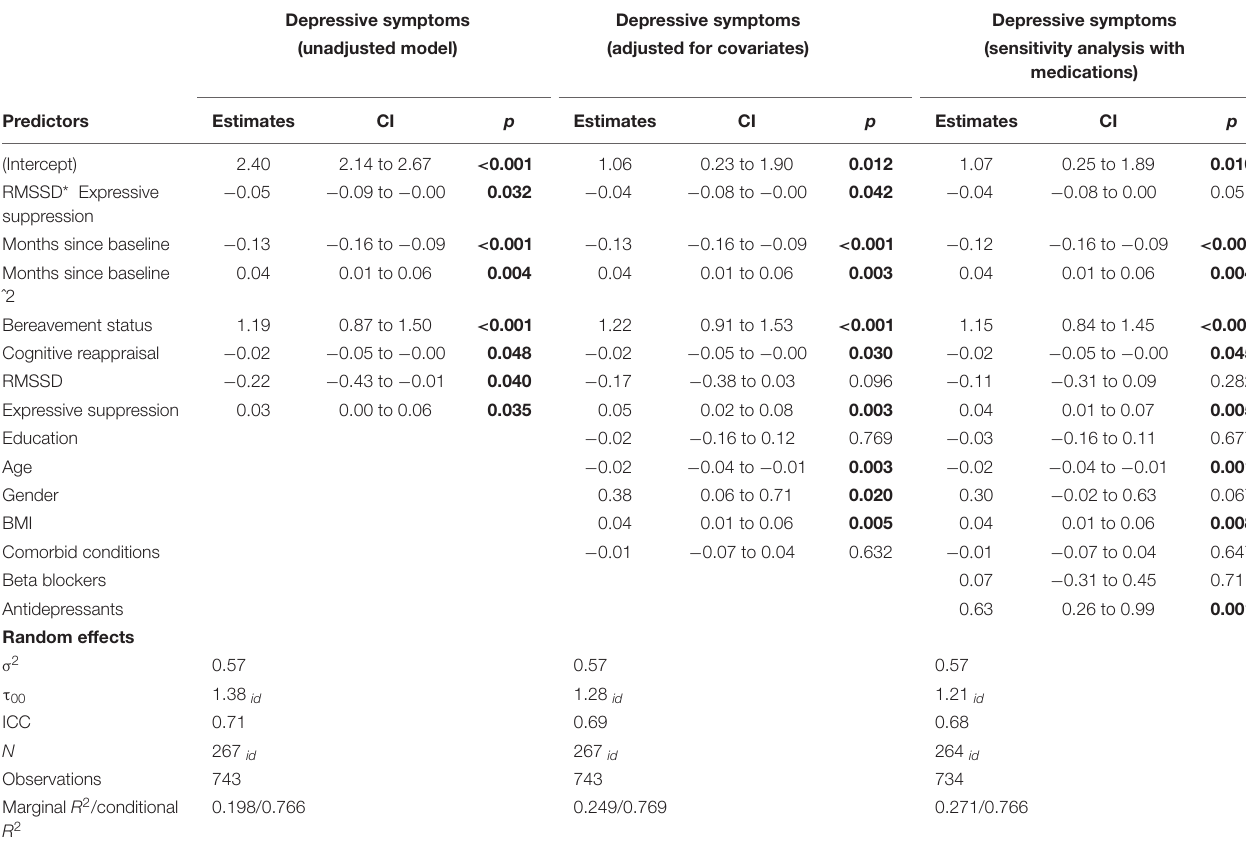
2 Indicates the squared, quadratic effect of time. Bold values indicate significant effects. The symbol “*” indicates the interaction between these two